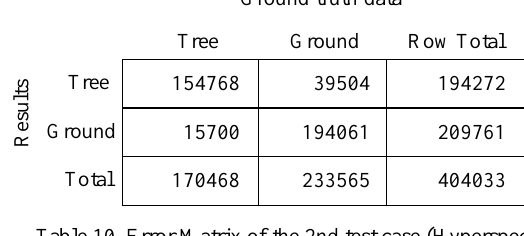
Table 10. Error Matrix of the 2nd test case (Hyperspectral